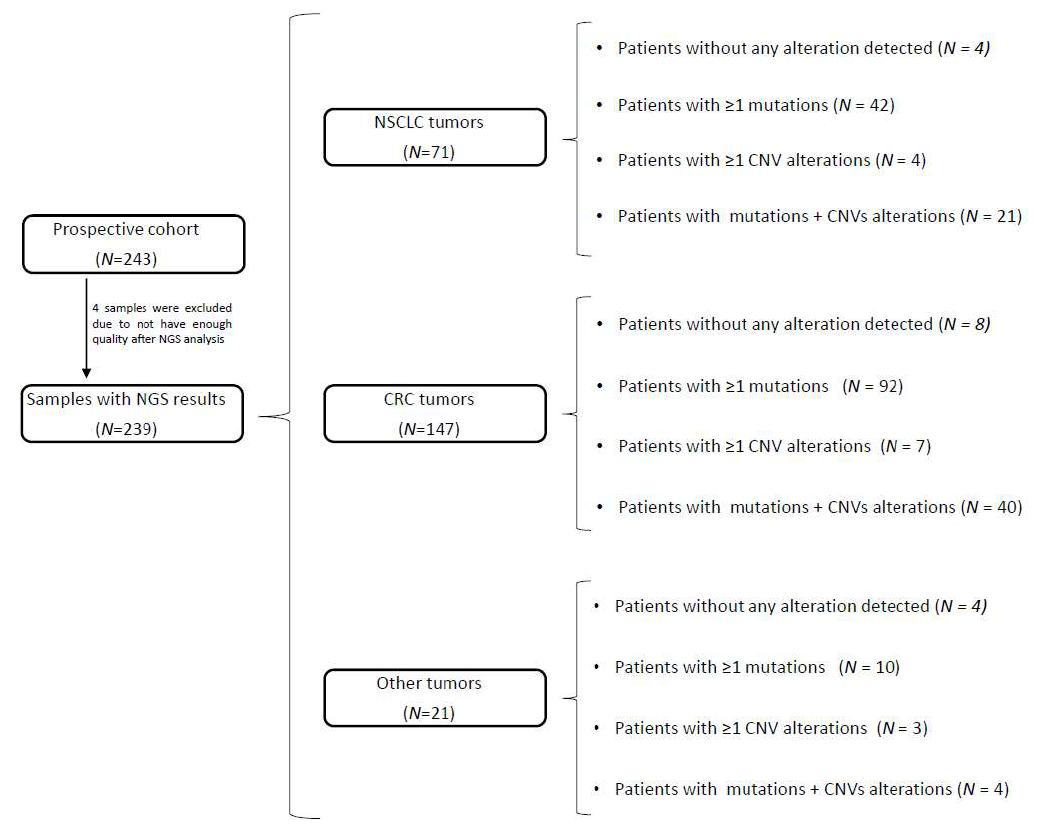
Figure 1. Flow chart of the study. Abbreviations: NGS—next-generation sequencing; NSCLC—non-small-cell lung cancer; CRC—colorectal carcinoma; and CNV—copy number variation.